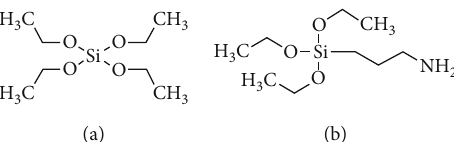
Figure 2: The chemical structure of polymer chain functionalization agents: (a) tetraethyl orthosilicate (TEOS); (b) (3- Aminopropyl)triethoxysilane